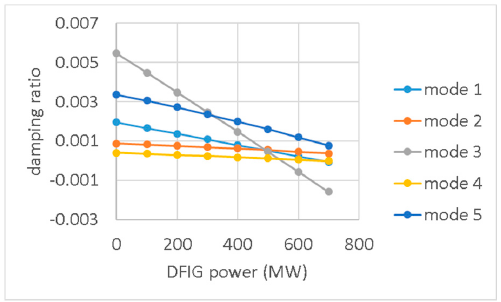
Figure 7. Damping ratios of torsional modes for the incorporation of the DFIG wind farm.